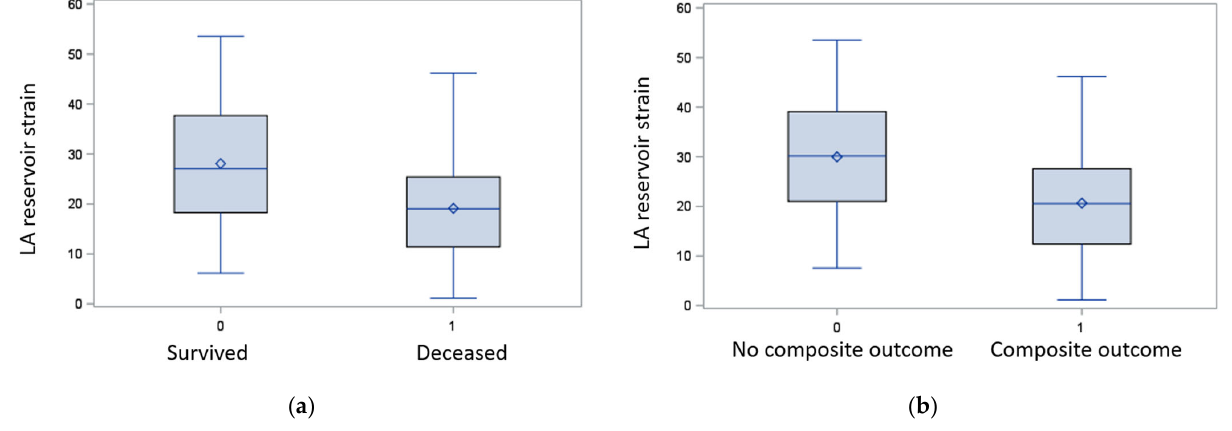
Figure 3. Boxplots of LA reservoir strain in RCM who experienced death ( a ) and composite events of death and cardiovascular hospitalizations ( b ). ( a ) LA reservoir strain is significantly decreased in patients who died (labeled 1) ( p = 0.002). ( b ) LA reservoir strain is significantly decreased in patients who experienced the composite endpoint of death or cardiovascular hospitalizations (labeled 1) ( p = 0.0008). LA = left atrium; RCM = restrictive cardiomyopathy. Table 3. ( A ) Cox proportional regression analysis of cardiac magnetic resonance imaging variables and survival. ( B ) Cox proportional regression analysis of cardiac magnetic resonance imaging variables and composite events.